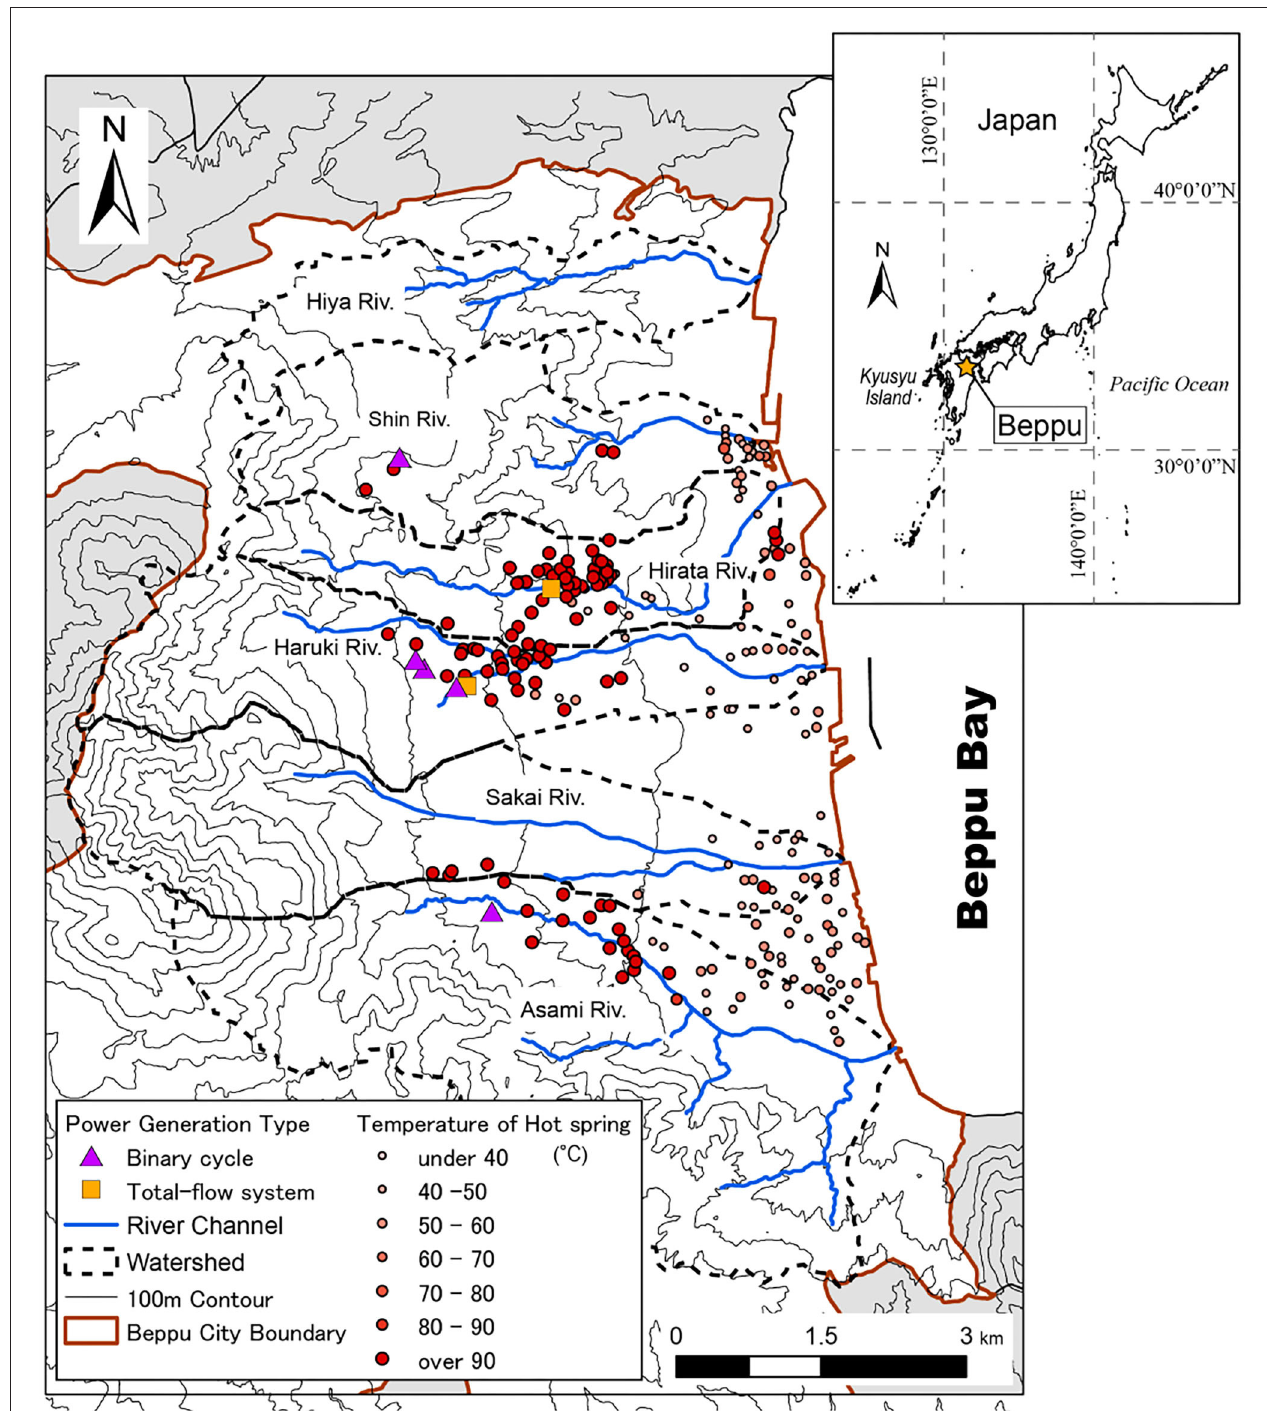
FIGURE 1 | Distribution of the hot springs and hot spring power plants with their associated temperatures in six river basins in the Beppu area (Yusa et al., 1989, 1990 ).